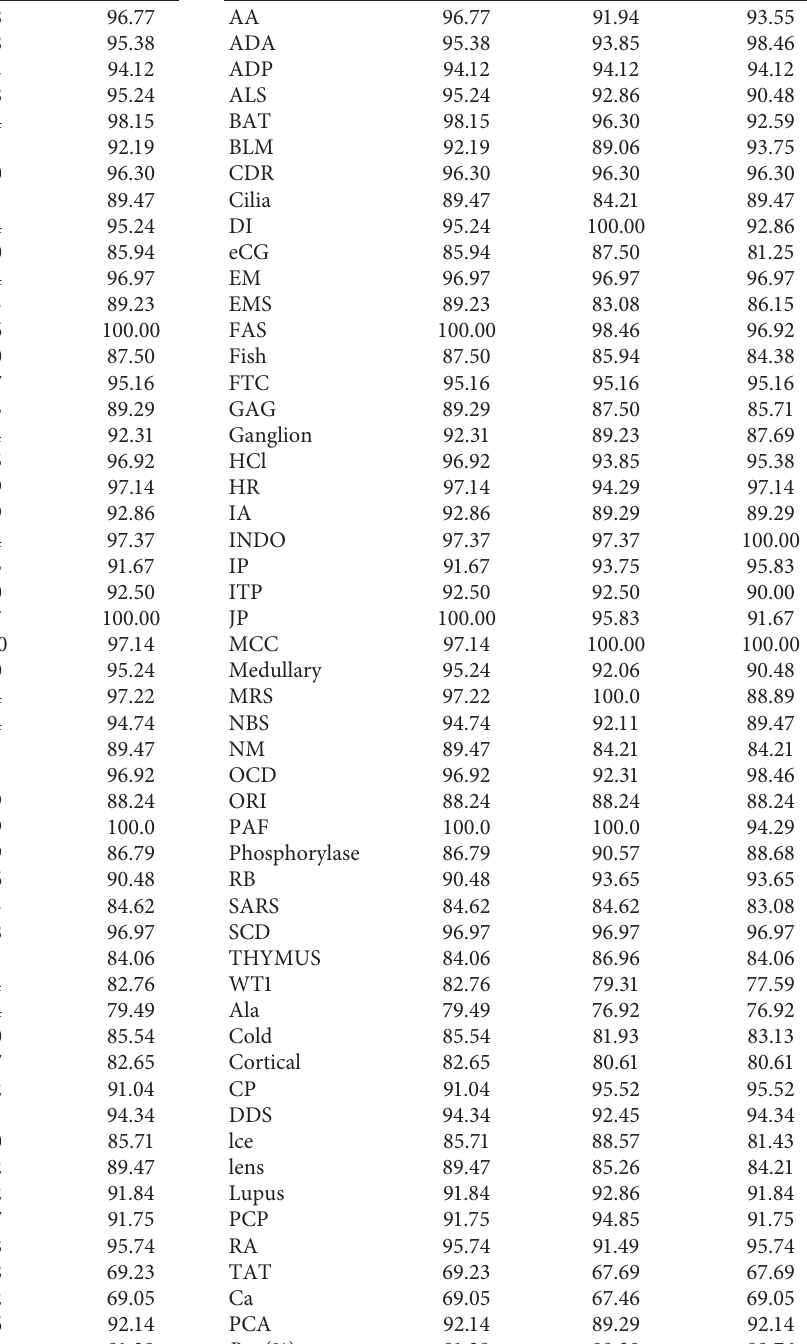
Table 3: Disambiguation accuracies of Experiment 4, Experiment 7, and Experiment